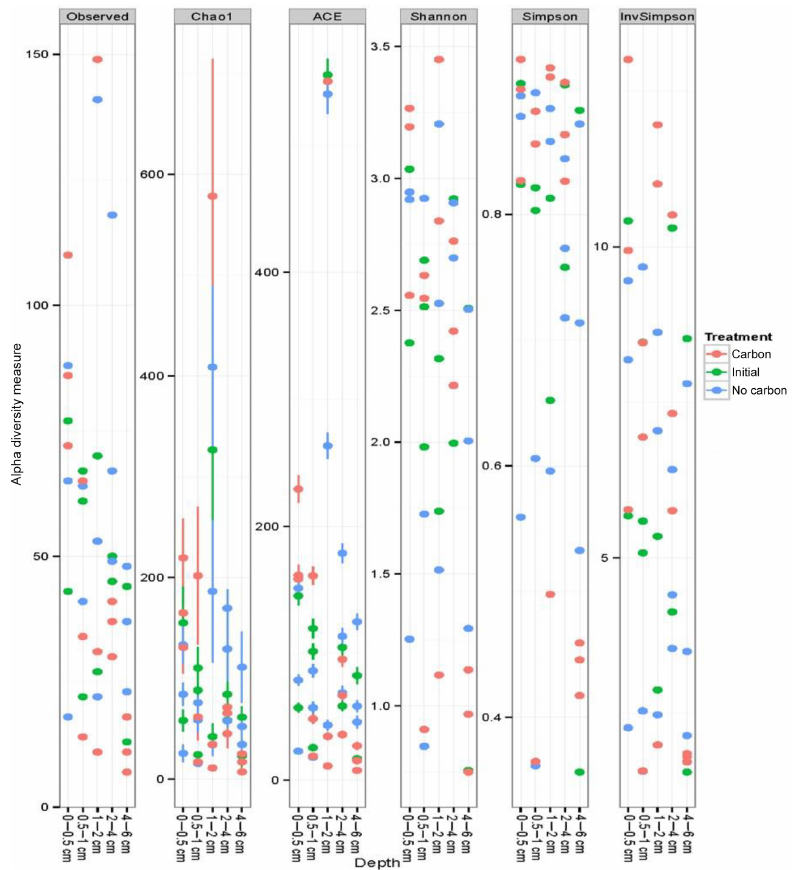
Figure 4. Alpha diversity metrics calculated on subsampled data. Observed: the number of operational taxonomic units (OTUs); ACE: abundance-coverage estimator; InvSimpson: Inverse Simpson diversity